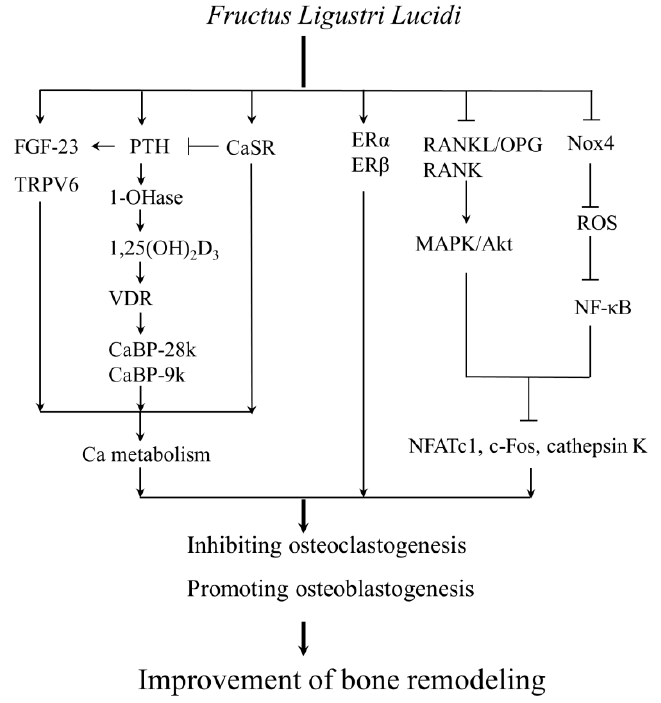
Figure 4. The revealed mechanisms targeted by Fructus Ligustri Lucidi in management of bone remodeling . Fructus Ligustri Lucidi improves Ca balance through upregulating the levels of PTH, 1-OHase, VDR, 1,25(OH) 2 D 3 , FGF-23, CaBP-9k, CaBP-28k, and TRPV6, and deregulating the levels